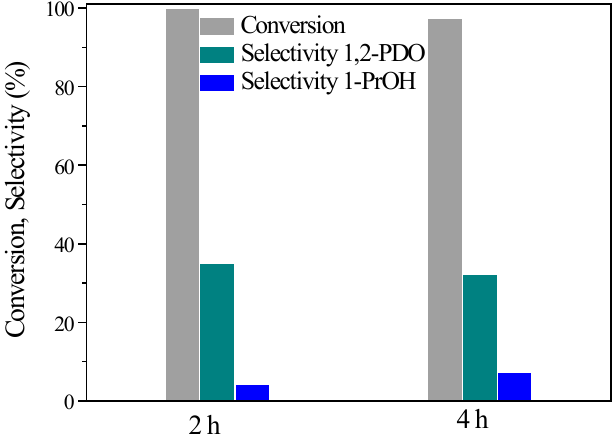
Figure 5. Effect of reaction time on glycerol conversion, 1,2-PDO selectivity and yield: 3.5 MPa N 2 initial pressure, 250 °C, 7.1 wt% EtOH, 11.3 wt% glycerol